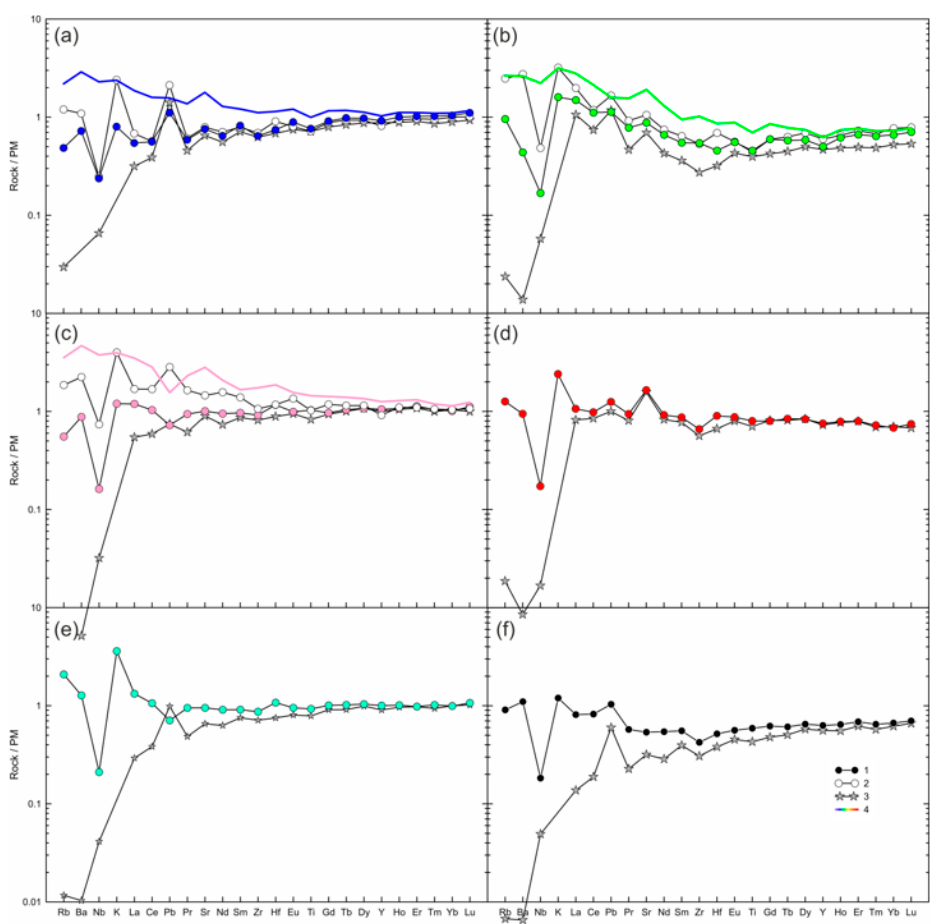
(Figure 7c). Overall, the studied Tumusun lherzolite xenoliths are fertile both in major and trace element composition.